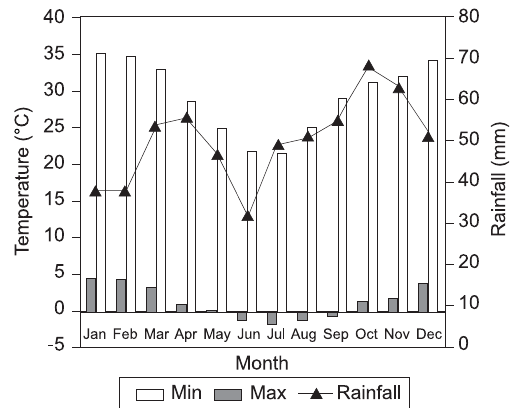
Fig. 2. The average monthly rainfall and the mean average minimum and maximum temperatures of the Kam- manassie Nature